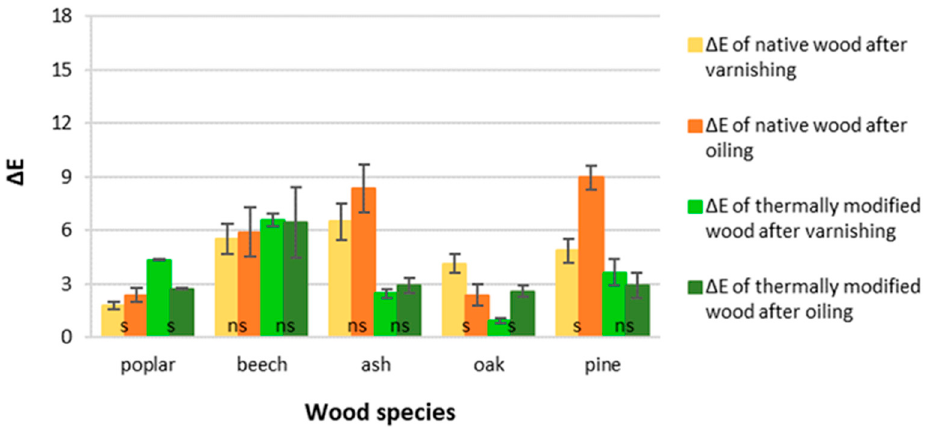
Figure 8. The total colour difference ∆ E of varnished, oiled native and thermally modified wood after photoaging (s—significant differences, ns—no significant differences between native wood after oiling and varnishing, or between thermally modified wood after oiling and varnishing, based on the t -test, p ≤ 0.05).